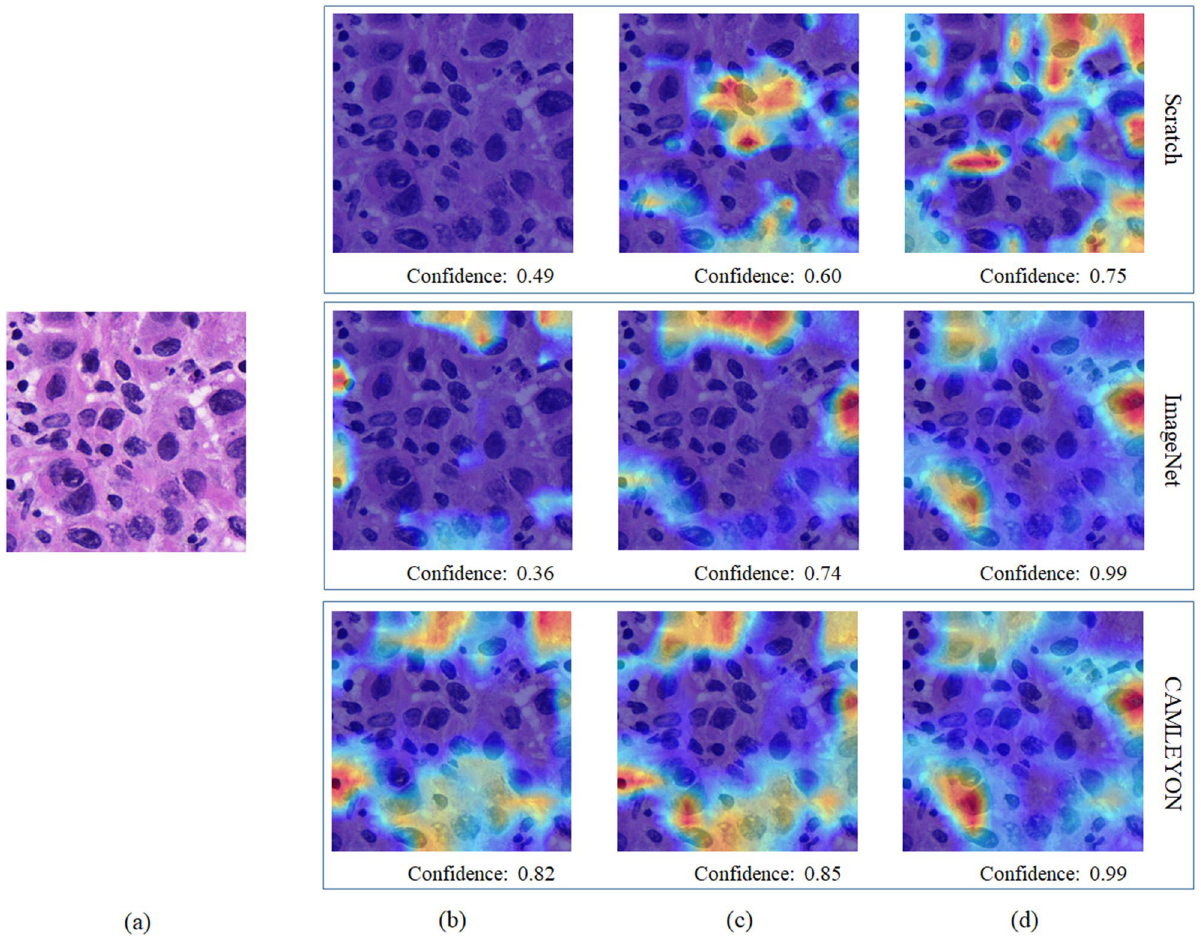
Figure 1. A validation workflow for transfer learning. ( a ) Two initial classification models are trained from two public datasets (i.e., ImageNet and CAMELYON16 datasets). ( b ) Private dataset from AMC is used to train classification models with different initial weights based on scratch- (random initialization), ImageNet- (pre- trained), and CAMELYON16-(pre-trained) based models. Different dataset ratios are selected at 2, 4, 8, 20, 40, and 100% of the total AMC dataset to train models for validation of the transfer learning